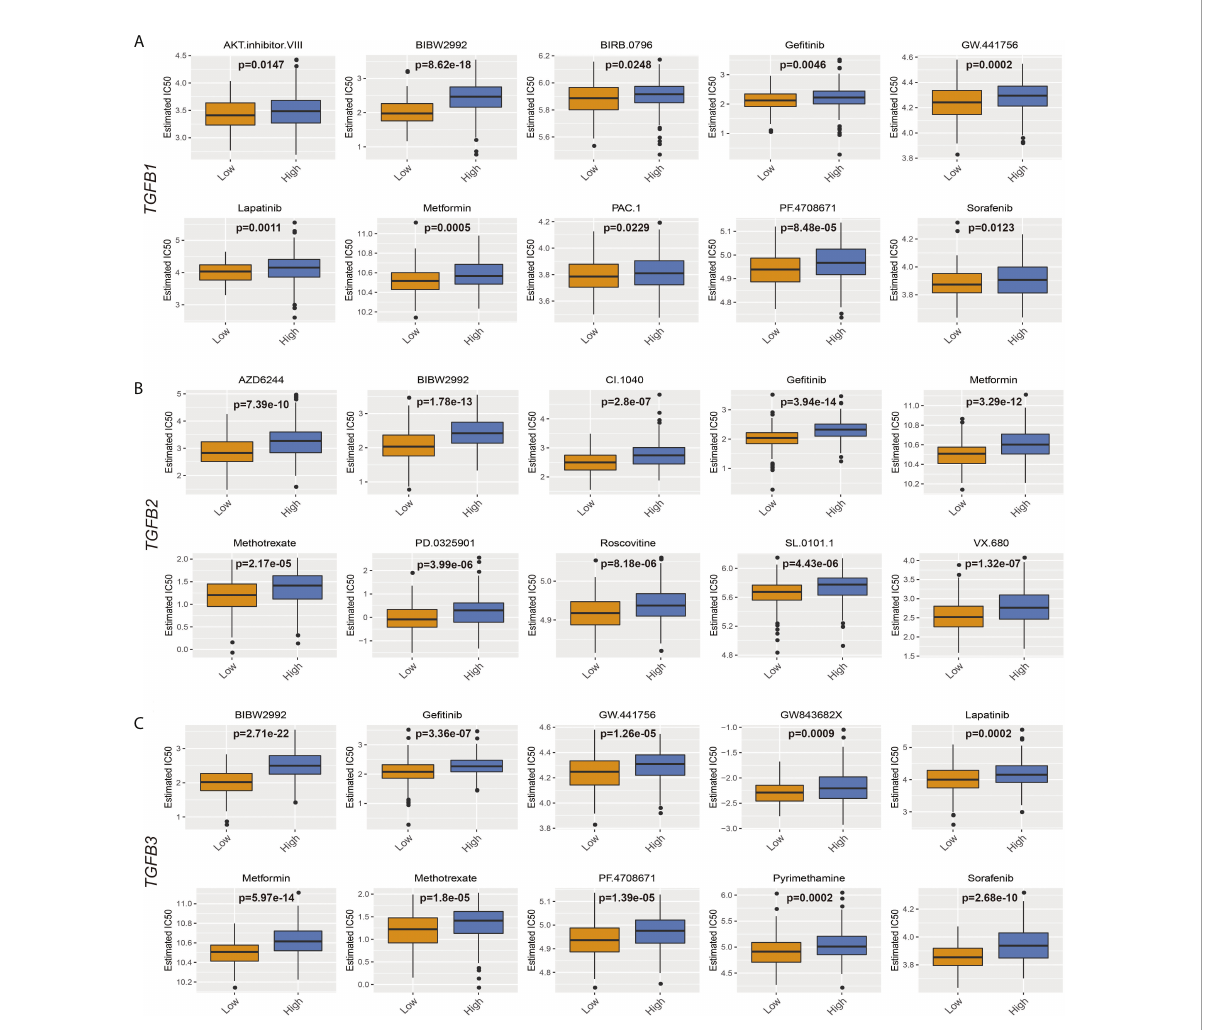
FIGURE 11 TGF b and chemotherapy in STAD. (A) Boxplots depicted the differences in the estimated IC50 levels of AKT.inhibitor.VIII, BIBW2992, BIRB.0796, Ge fi tinib, GW.441756, Lapatinib, Metformin, PAC.1, PF.4708671 and Sorafenib between the high and low TGF b 1 groups. (B) Boxplots depicted the differences in the estimated IC50 levels of AZD6244, BIBW2992, CI.1040, Ge fi tinib, Metformin, Methotrexate, PD.0325901, Roscovitine, SL.0101.1 and VX.680 between the high and low TGF b 2 groups. (C) Boxplots depicted the differences in the estimated IC50 levels of